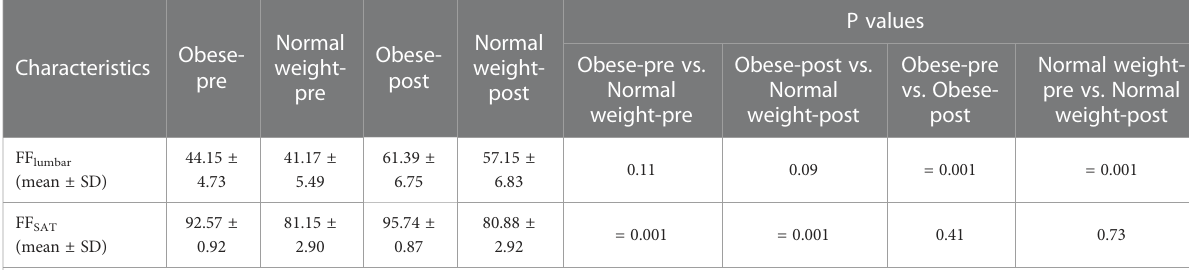
TABLE 5 The fat fraction values of lumbar vertebra and subcutaneous fat in the second cohort.